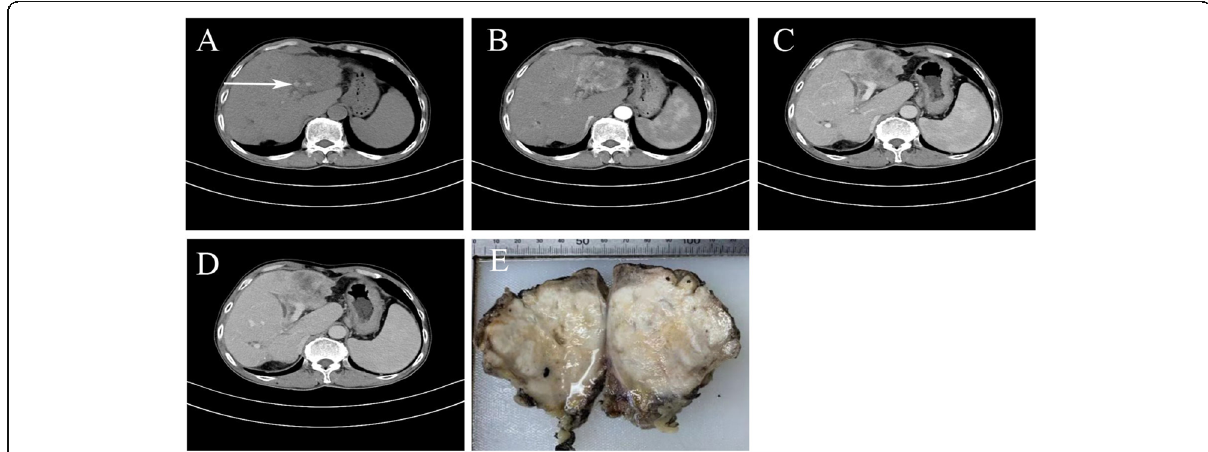
Fig. 1 Results of preoperative CT, postoperative gross examination. a Abdominal non-contrast CT scan revealed a low density mass measuring approximate 10 cm in diameter at the left hepatic lobe and intrahepatic bile ducts with multiple stones (white arrow). b Enhanced CT scan (arterial phase) revealed a heterogeneous enhanced mass in the left lobe of the liver. c Enhanced CT scan (portal phase) revealed a persistent inhomogeneous enhanced mass and formation of tumor thrombus in the left branch of portal vein. d Enhanced CT scan (delayed phase) revealed a persistent inhomogeneous enhanced mass. e Gross examination of the resected liver mass indicated an irregular, white solid tumor without a fibrous capsule. The border between the tumor and normal liver tissue was